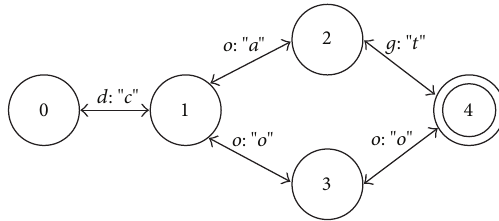
Figure 3: Finite state transducer encoding the relation { (dog, cat), (dog, cow) }